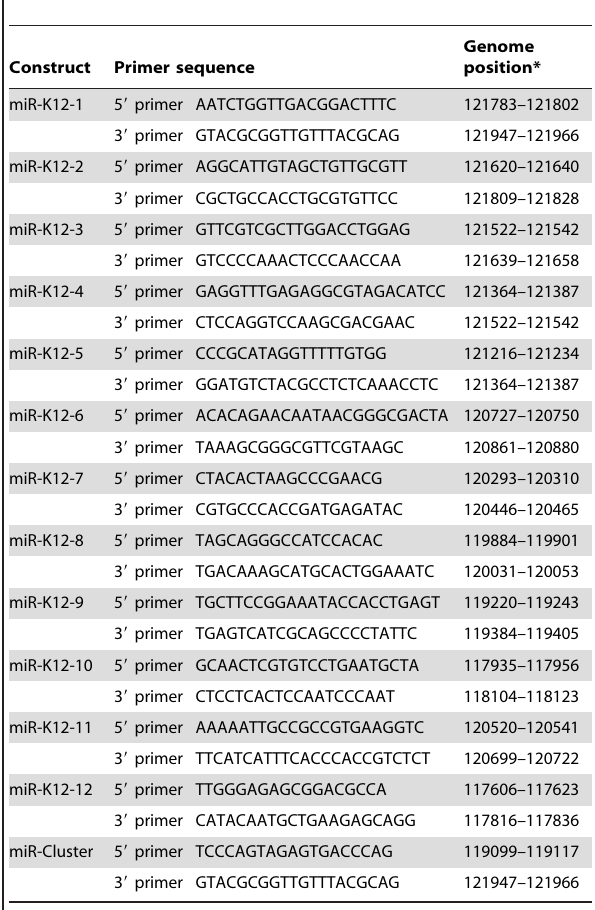
Table 1. Primer pairs for cloning KSHV pre-miRNA expression